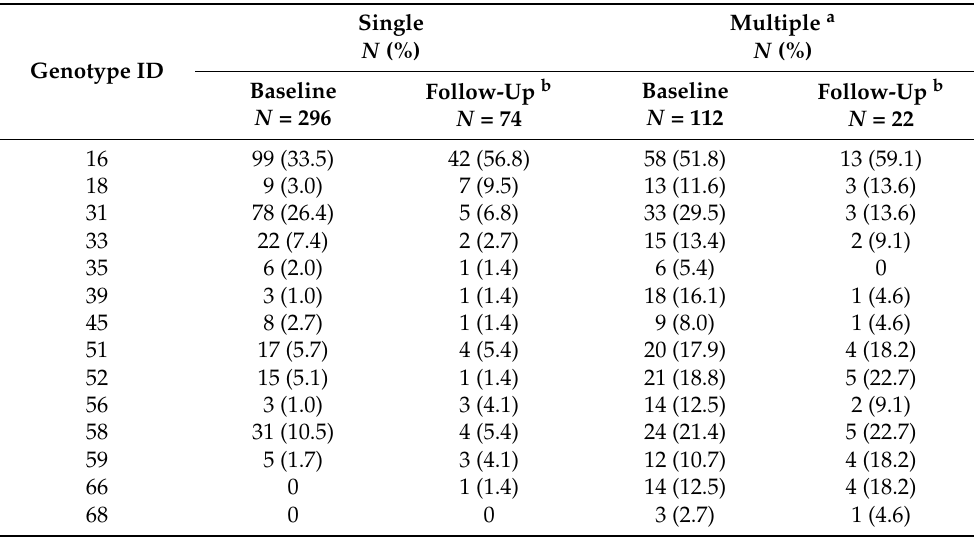
Table 2. High-Risk Genotypes distribution at baseline and at 3–9 months follow-up